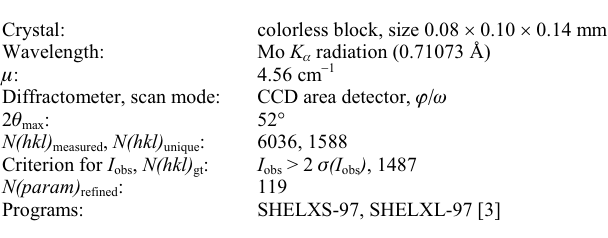
Table 1. Data collection and handling.